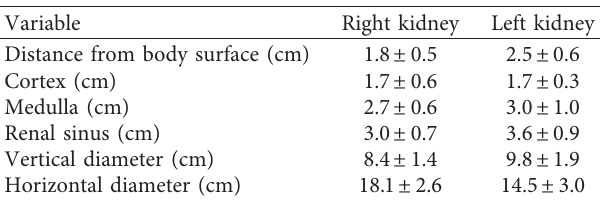
Table 1: Dimensions (means ± SD) of the right and left kidneys imaged by ultrasound, from the upper right and caudal left paralumbar fossa in healthy camels [18].